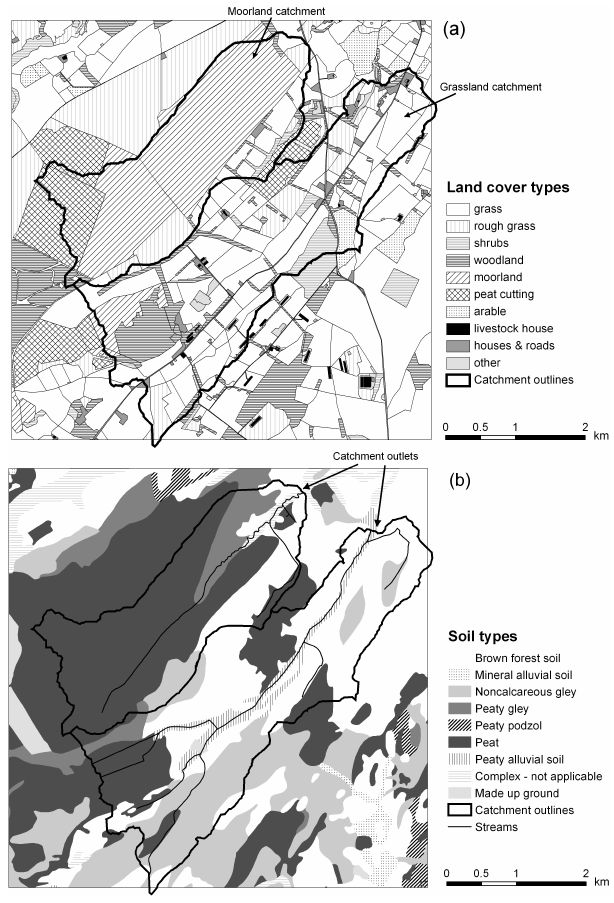
Fig. 1. Maps of land cover (a) and soil types 1 (b) within the study landscape with outlines of the two studied catchments 2